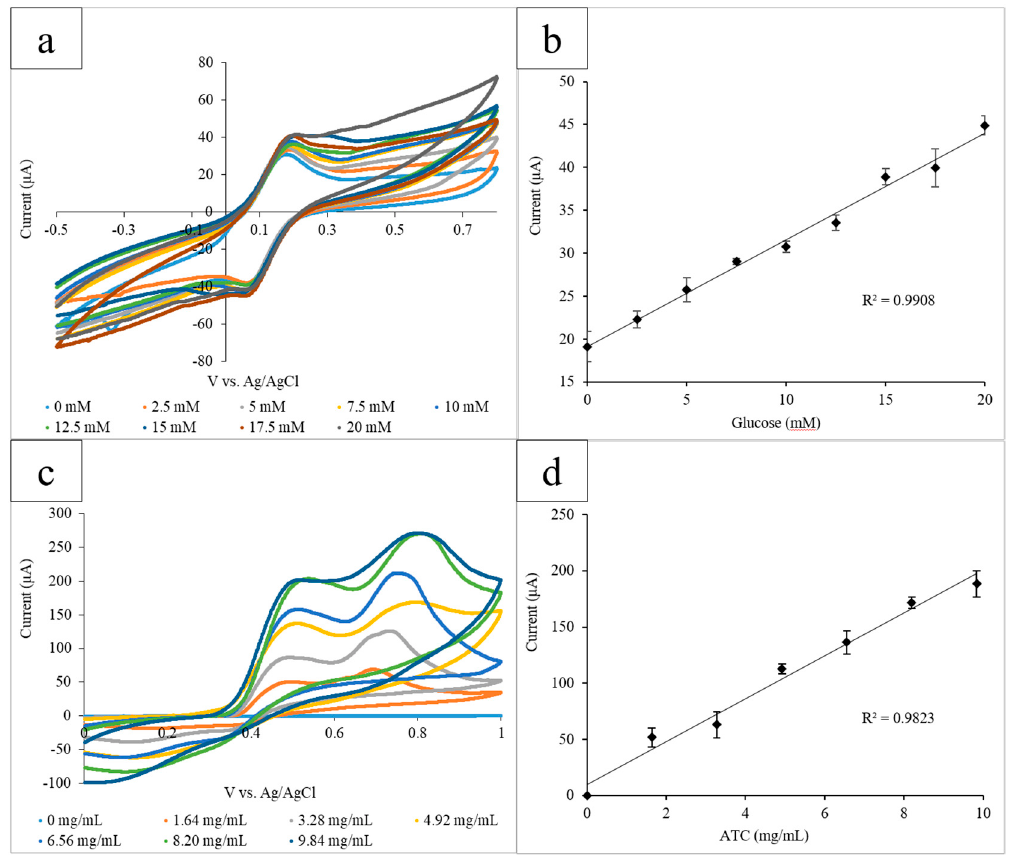
Figure 4. ( a ) Cyclic voltammograms for the increasing glucose concentrations measured using the bubble wrap platform. The current output at the oxidation peak (0.45 V) increased proportionally with the glucose concentration; ( b ) the calibration curve measuring the current output at 0.45 V vs. glucose concentration. A linear correlation between the current and concentration was found to have an R 2 value of 0.991; ( c ) the cyclic voltammograms for increasing the ATC concentrations measured using the bubble wrap platform. The current output at the oxidation peak (0.60 V) increased proportionally with the ATC concentration; and ( d ) the calibration curve measuring the current output at 0.60 V vs. glucose concentration. A linear correlation between the current and concentration was found to have an R 2 value of 0.982.